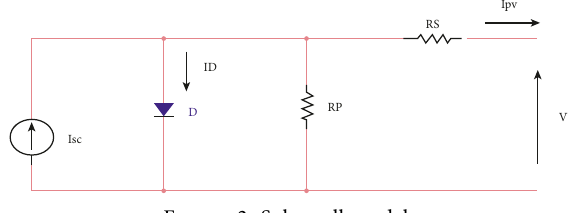
Figure 2: Solar cell